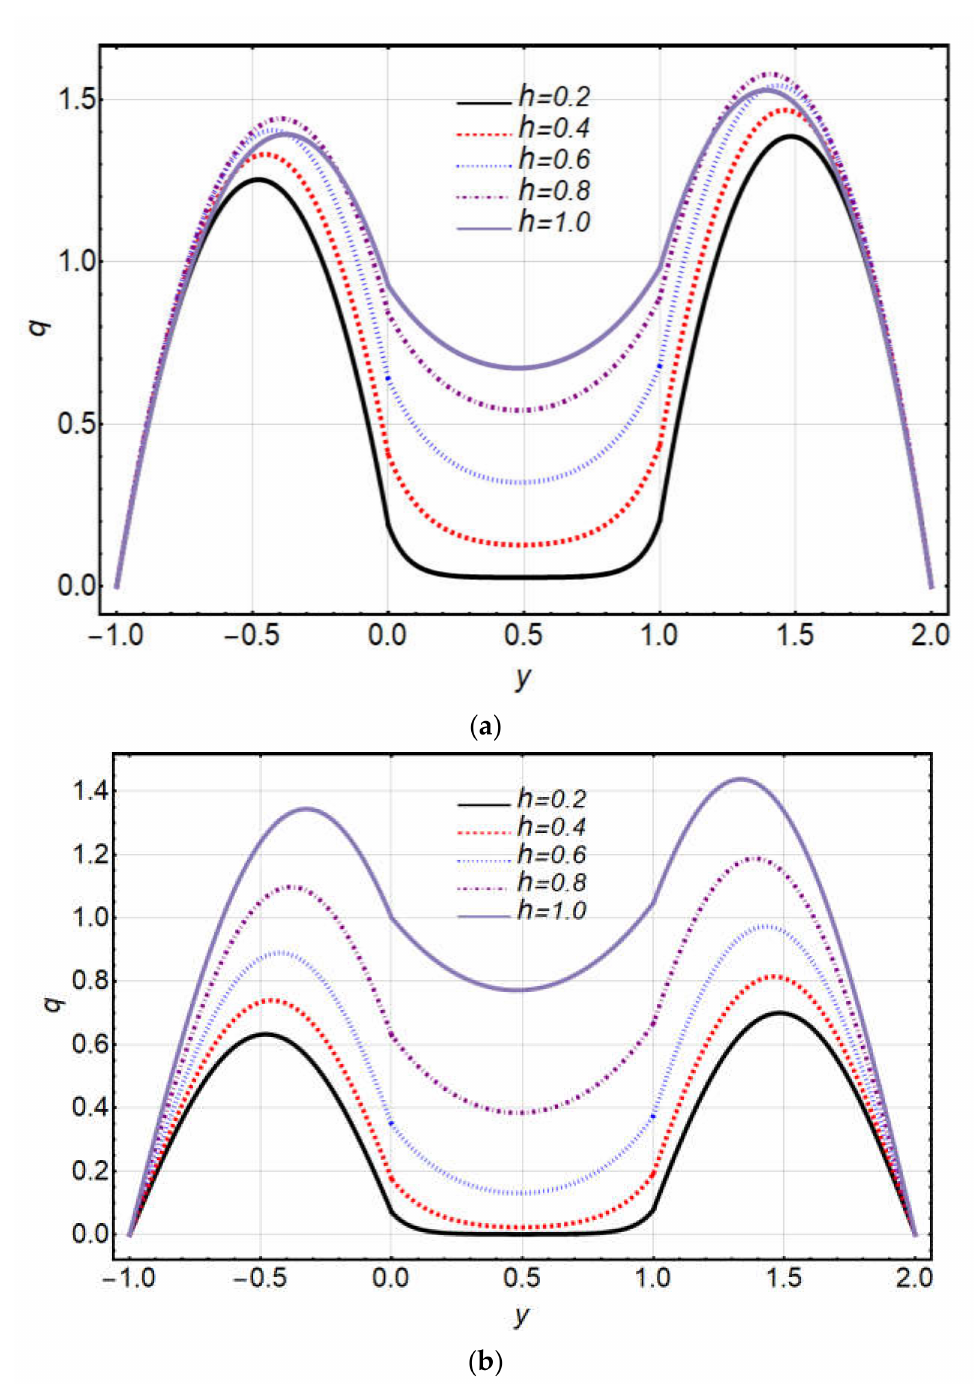
Figure 3. Velocity distribution of h : ( a ) axial, ( b )